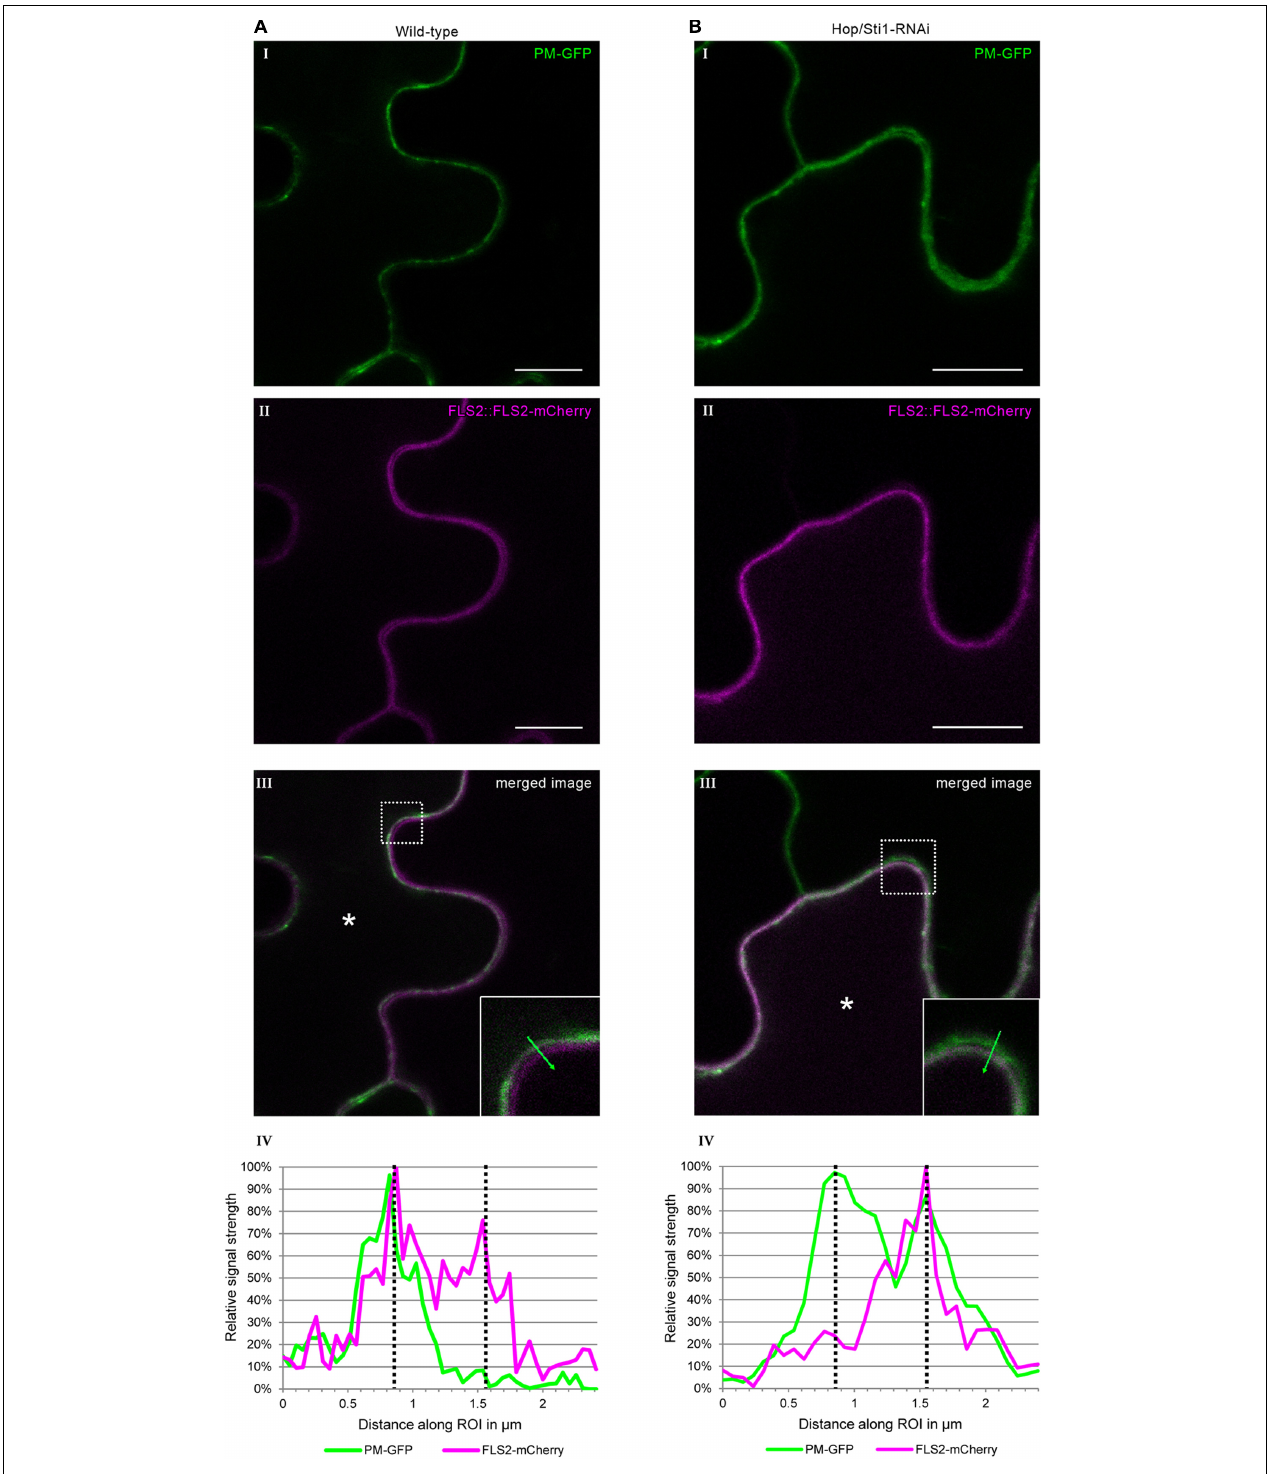
FIGURE 3 | Assessment of FLS2 plasma membrane-targeting using confocal laser scanning microscopy. Coexpression of FLS2-mCherry under control of its own promoter with a plasma membrane-GFP marker. (A) In wild-type plants. (B) In Hop/Sti1-RNAi line #61. (I) Plasma membrane-GFP marker. (II) FLS2-mCherry. (III) Merged channels. The dotted box is magnified in the lower right corner, an asterisk marks a coexpressing cell. Scale bars represent 10 µ m. (IV) A diagram of the fluorescence signal intensities along the region of interest (ROI, green arrow) shown in the inlay in panel III. Dotted lines indicate the intensity maxima representing the plasma membranes of two neighboring